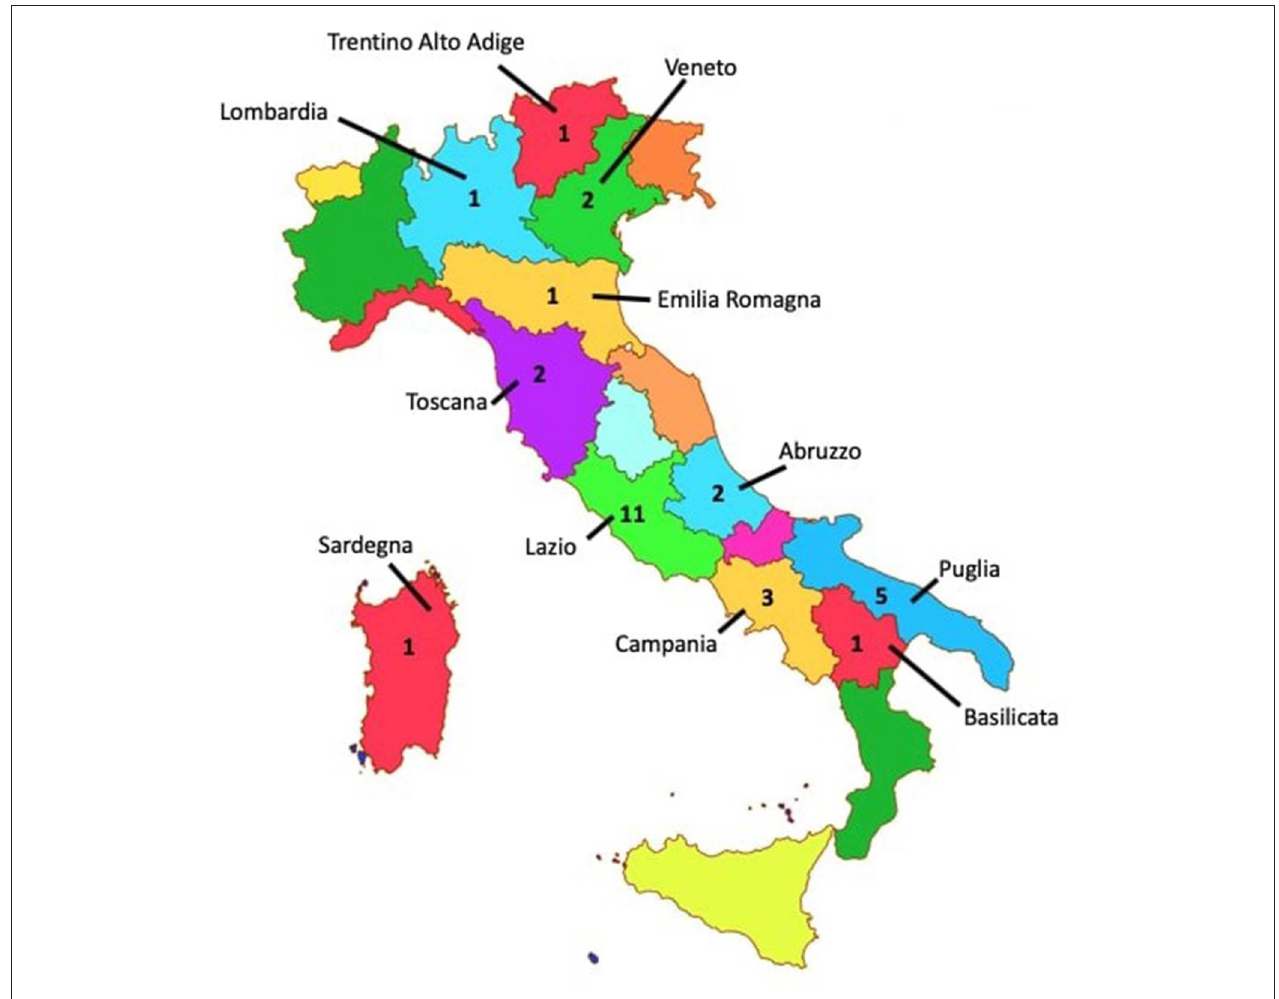
FIGURE 2 | Map of the 20 Italian regions with number of patients per region (zero where not indicated). In accordance with the diagnostic criteria for PANDAS established by Swedo et al. (2), we selected children with the following characteristics: - Presence of OCD and tics according to the diagnostic criteria for tics and OCD of the DSM-IV and DSM-V; - Onset in childhood (from 3 years to puberty); - Sudden onset and cyclic exacerbation of more severe symptoms , as the patient’s parents consult doctors when the child begins to show tics, OCD and other pathological behaviors, or a return of past neuropsychiatric symptoms; - Temporal connection between symptom onset and GAS infection [positive pharyngeal swab, high anti-streptolysin O titer; ASLOT (2)], as sometimes the infection has progressed by the time of disease onset (also 6–9 months), although most children experience symptom onset at 6 weeks; - A connection with neurological abnormalities , including cognitive difficulties, worsening academic performance, dysgraphia, ADHD, depression, separation anxiety, irritability, emotional lability, oppositive behavior, sleeping difficulties, choreiform movements, and Romberg test